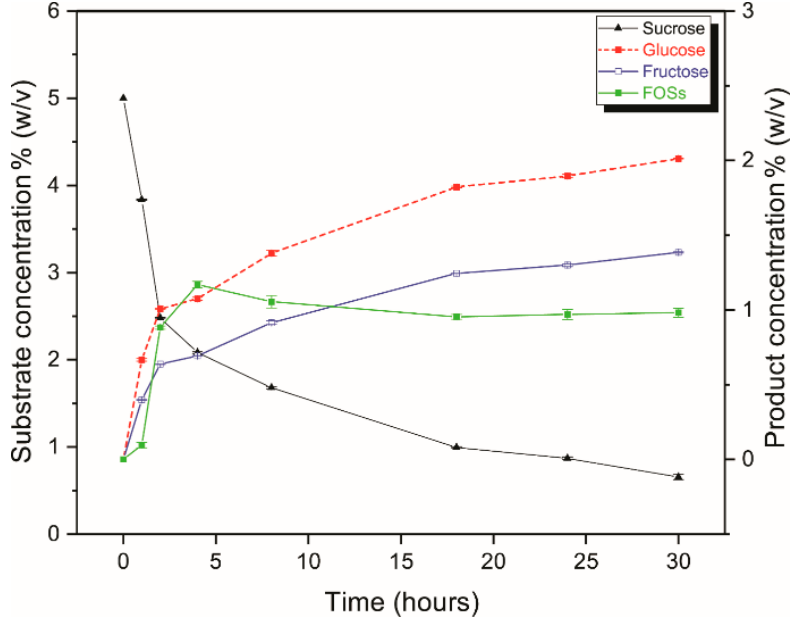
Figure 6. Production of IFOs by R483A-LrInu CLEAs. Reaction condition: 5 U/mL R483A-LrInu CLEAs, 5% ( w / v ) sucrose, 50 mM acetate buffer (pH 5.5) at 30 °C. The sugar content was analyzed by HPLC with a Sugar-Pak™ column.